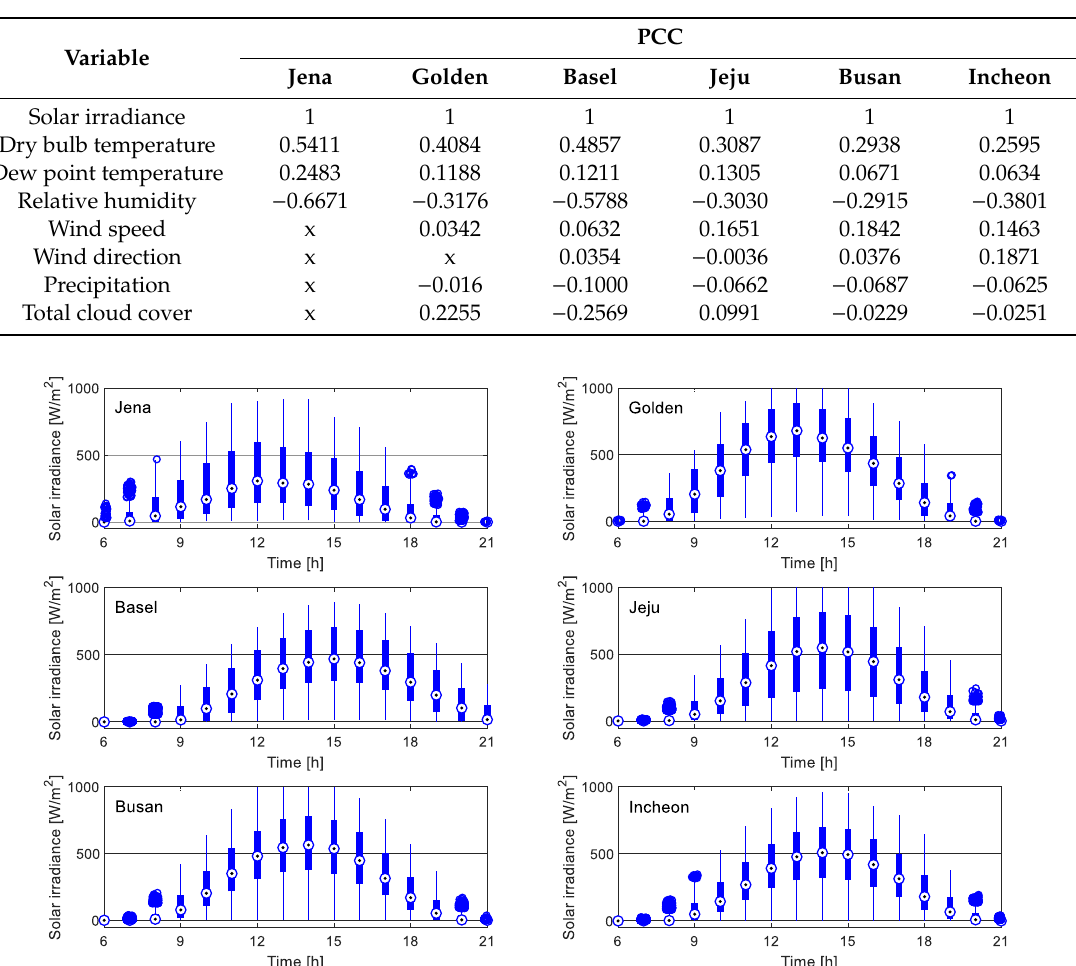
Figure 4. Distribution of hourly solar irradiance of all the six datasets.